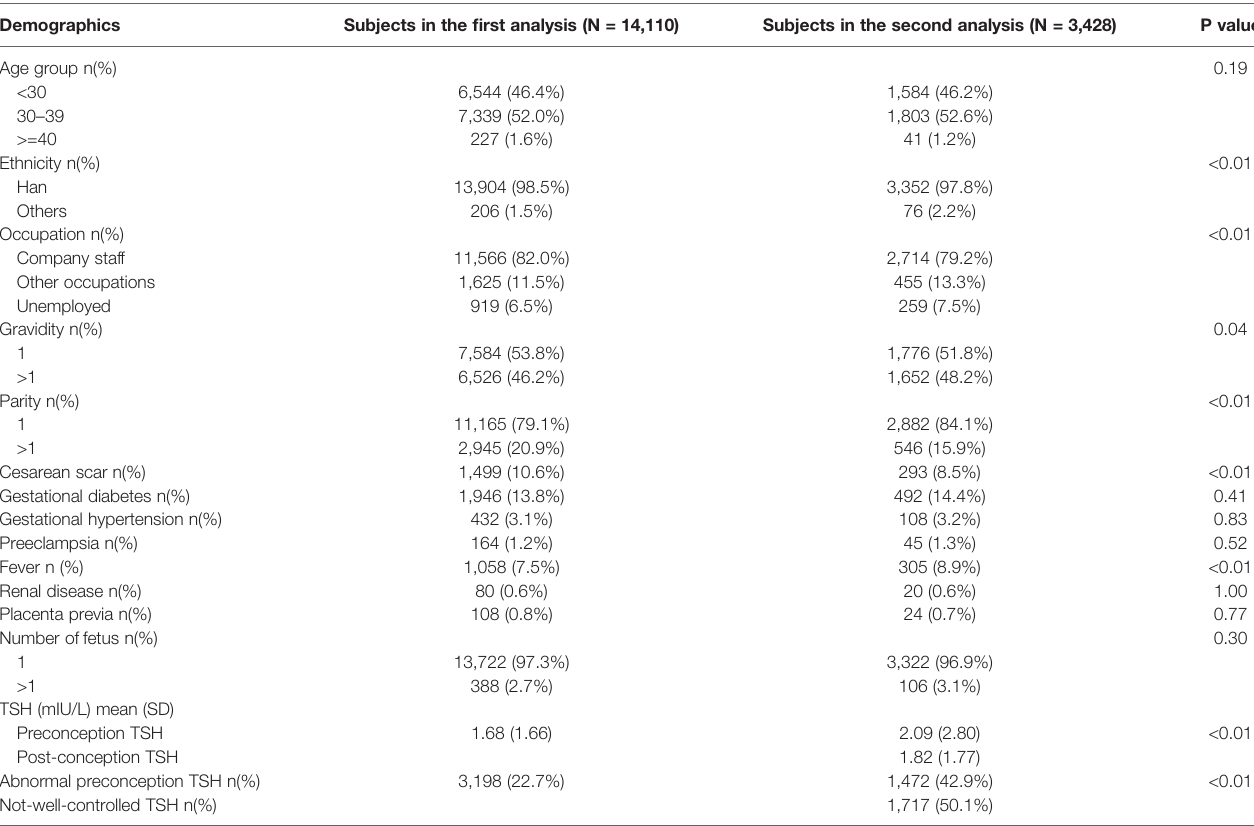
TABLE 1 | Baseline predictive characteristics for subjects in the fi rst and second